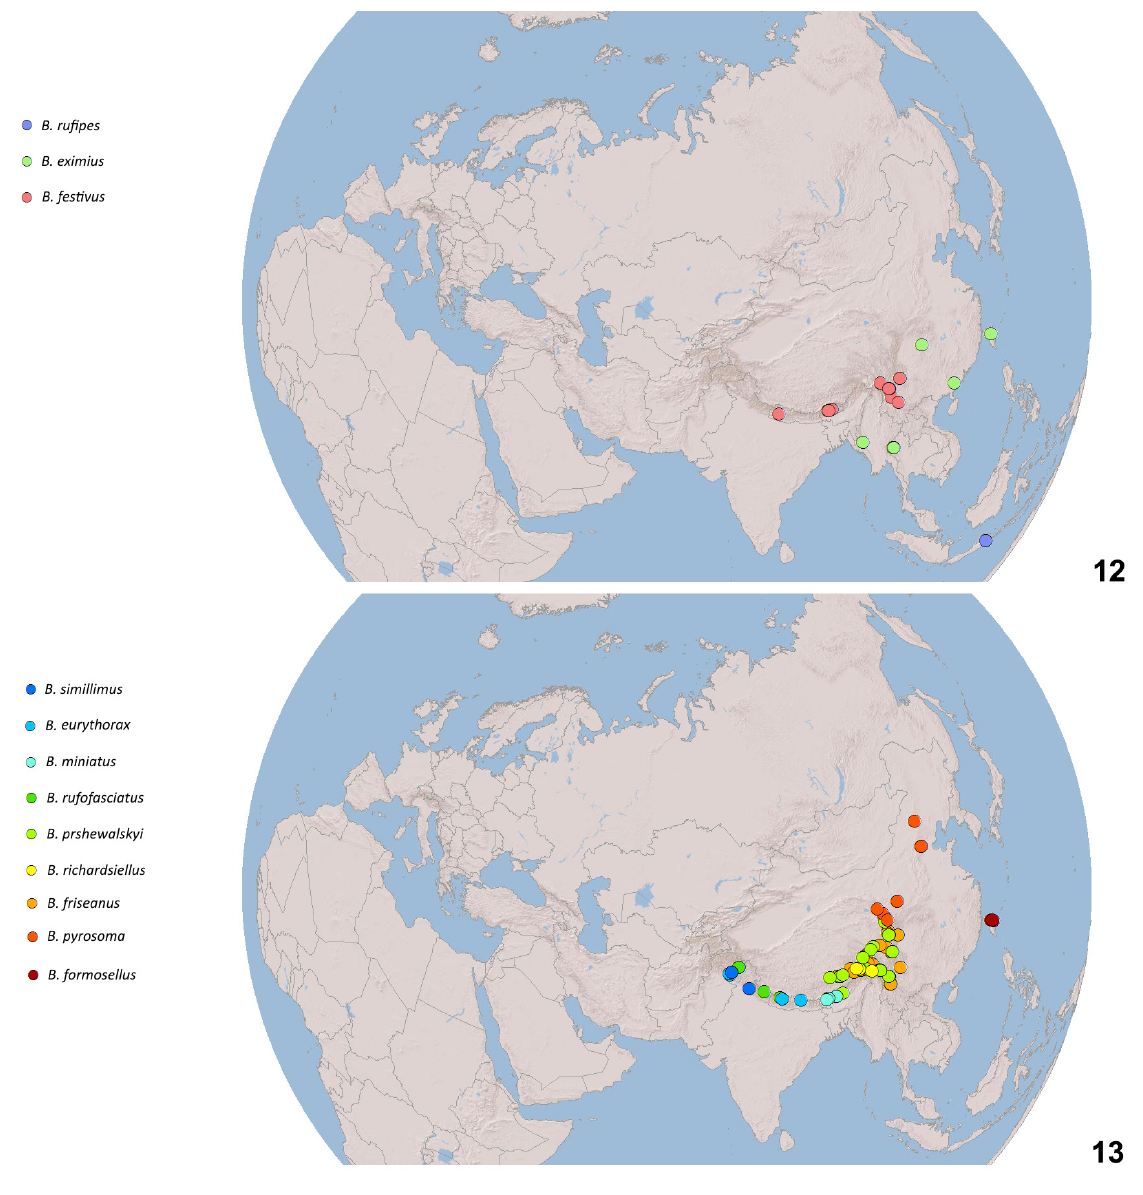
Figs 12‒13. Maps of sequenced samples. 12 . The rufipes -group and festivus -group. 13 . The rufofasciatus - group as recognised as species from the UHF-PTP analysis in Fig. 10. Keys to the coloured symbols are shown on the left (in some cases symbols on the map for one species may overlie symbols for another). Maps projected onto a sphere in ArcGIS using World_Shaded_Relief basemap © 2014 ESRI and showing boundaries between countries as recognised by the